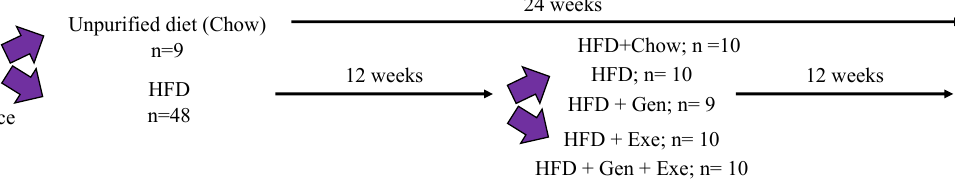
Figure 1. Study Design. High-fat, high-sugar diet, HFD; high-fat, high-sugar diet + genistein (HFD + Gen); high-fat, high-sugar diet + exercise (HFD + Exe); high-fat, high-sugar diet + genistein + exercise (HFD + Gen + Exe). All mice fed with a HFD (20% carbohydrate, 20% protein, and 60% fat) water was supplemented with 42 g/L of sweetener (55% fructose and 45% sucrose). Exe protocol consisted of a 3-week graded increase in exercise duration and intensity as follows: week 1, 10 min at 10 m/min; week 2, 20 min at 10 m/min; week 3, 30 min at 12 m/min; weeks 4–12, 30 min at 15 m/min. This exercise protocol was designed to align with recommendations for cardiovascular health. Gen was included in the mice feed at a concentration of 600 mg of genistein/kg of diet. Purple arrows describe randomization.